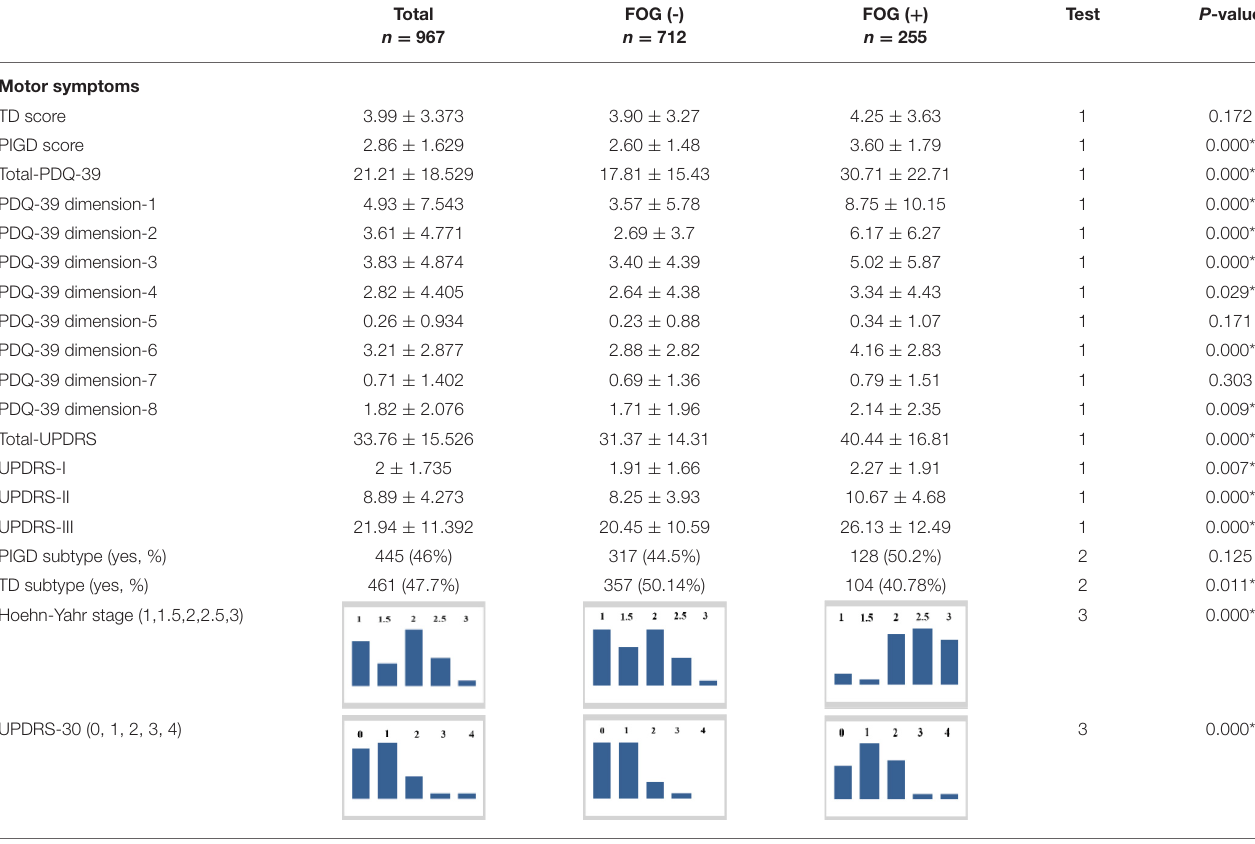
TABLE 2 | Baseline characteristics of motor symptoms of the